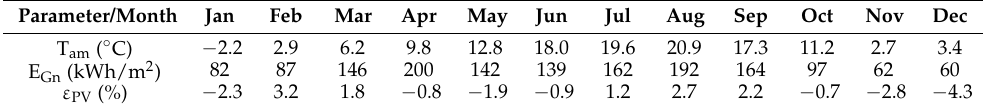
Table 6. Weather conditions and the relative differences of photovoltaic electrical energy output.